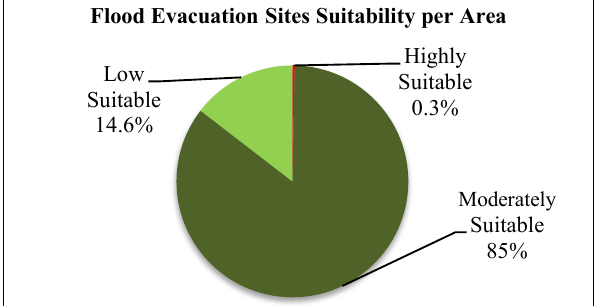
Figure 3. Statistics of Area per Suitability Scale Graph